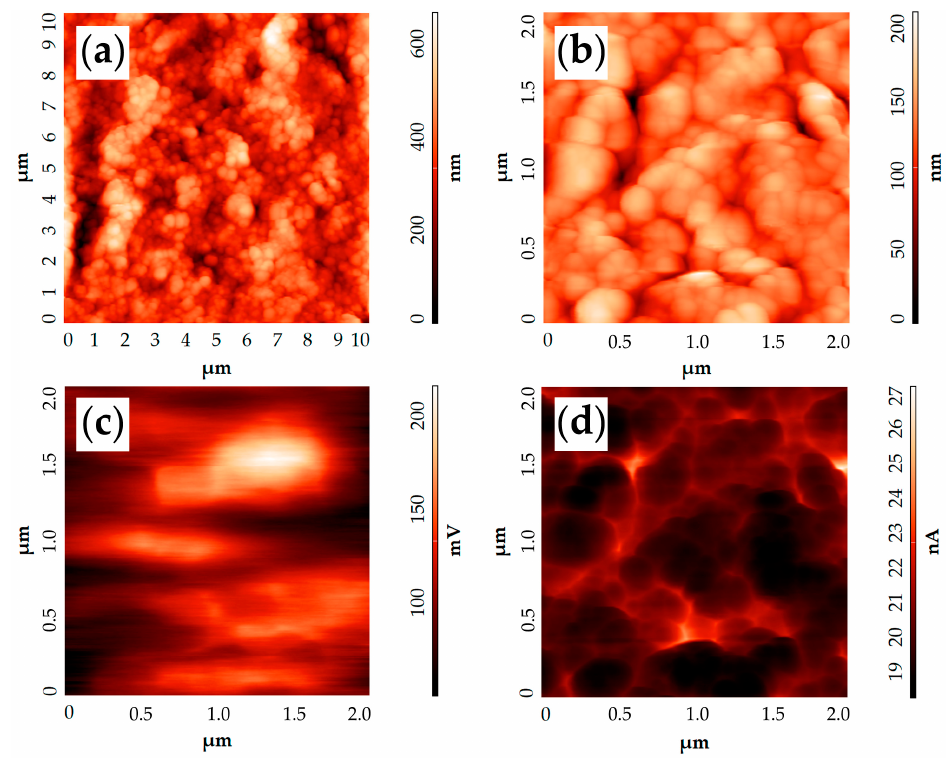
Figure 8. AFM results of the NiO—SDC film under study: ( a , b )—topography; ( c )—surface potential distribution map; ( d )—capacitance gradient map of the “probe tip ‐ sample microregion” capacitor.